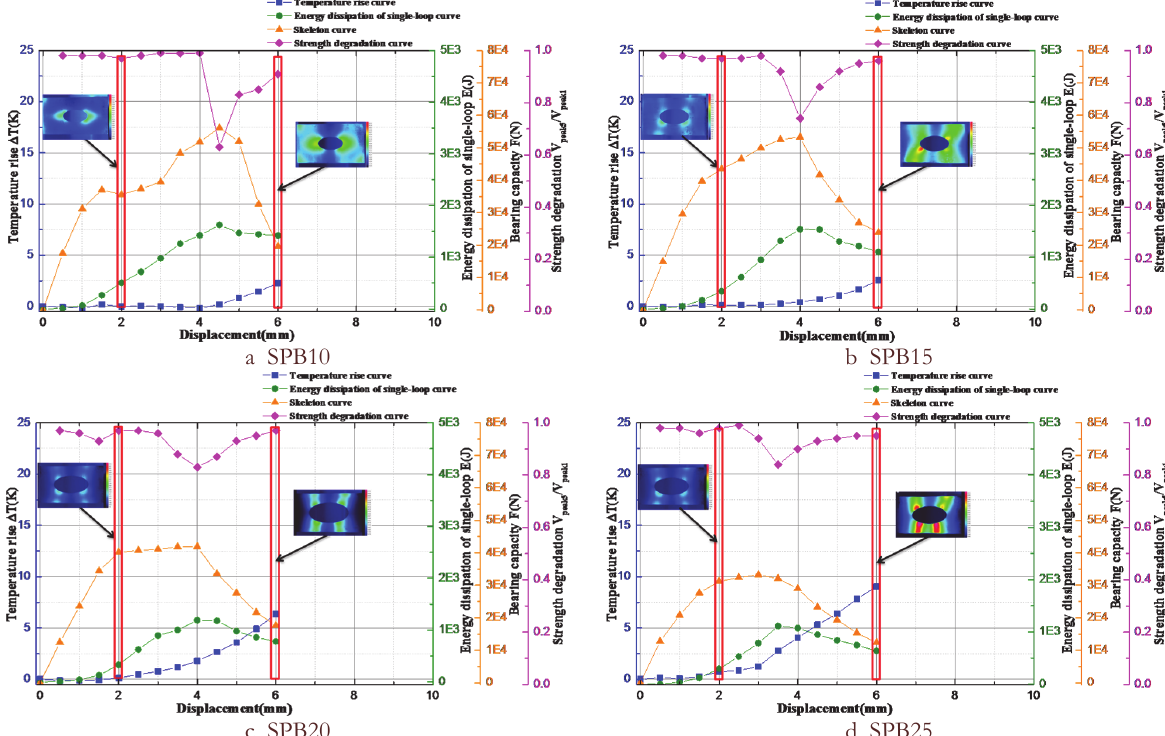
Figure 10: The relationship between the mechanical performance and average temperature rise for dampers of SPB with four different opening